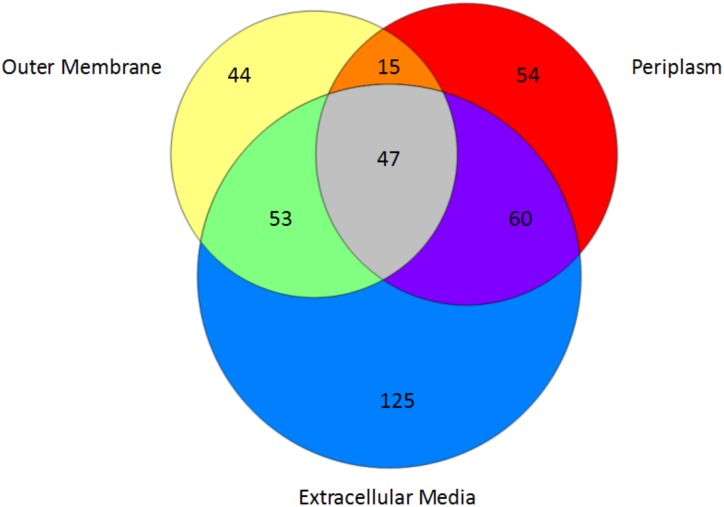
Comparison of the number of identified proteins and their overlap observed in the outer membrane, periplasm and extracellular medium fractions.